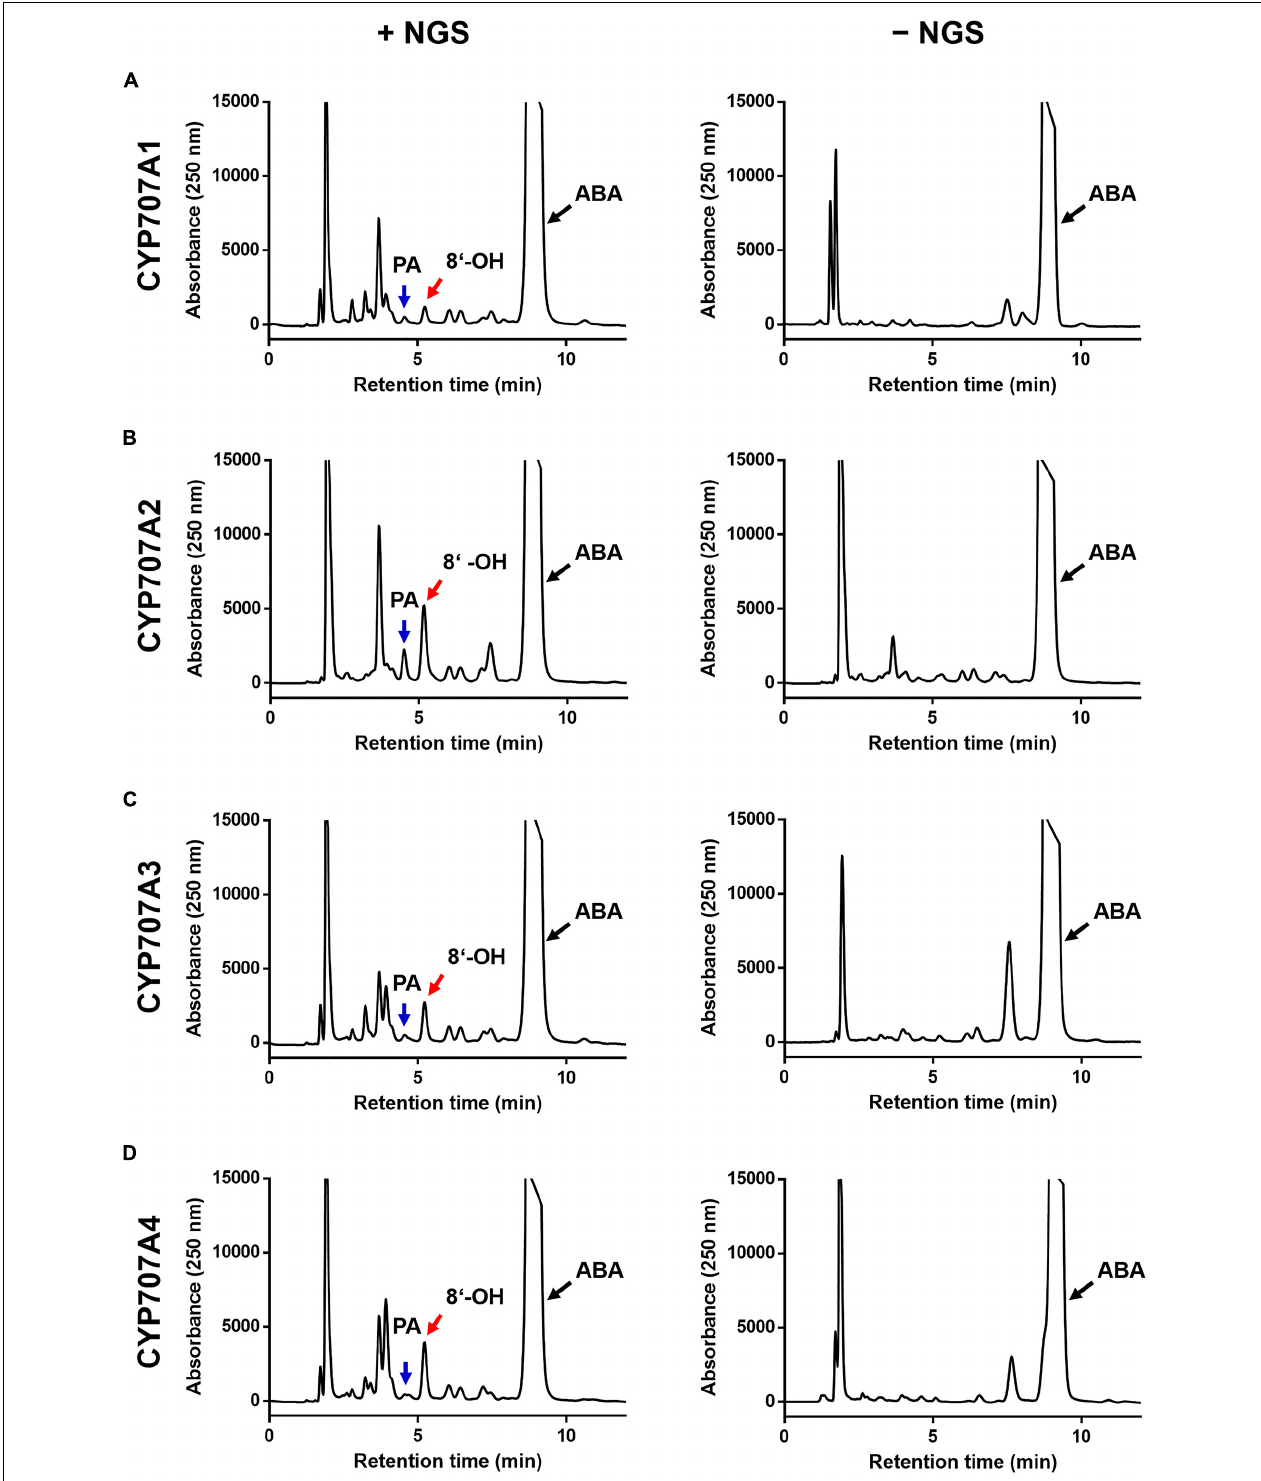
FIGURE 2 | ABA hydroxylation activity of CaCYP707As. Characterization of CaCYP707A1 (A) , CaCYP707A2 (B) , CaCYP707A3 (C) , and CaCYP707A4 (D) function in ABA hydroxylation. CYP707A1, 2, 3, and 4 proteins expressed in E. coli were incubated with ABA in the presence (left; +NGS) or absence (right; –NGS) of a NADPH-generating system, and the catabolites were analyzed by HPLC. The peaks marked by red and blue arrows are 8 (cid:48) -hydroxy ABA (8 (cid:48) -OH) and phaseic acid (PA), respectively, whereas the peaks marked by black arrows are abscisic acid (ABA). The experiments were performed three times with similar results.